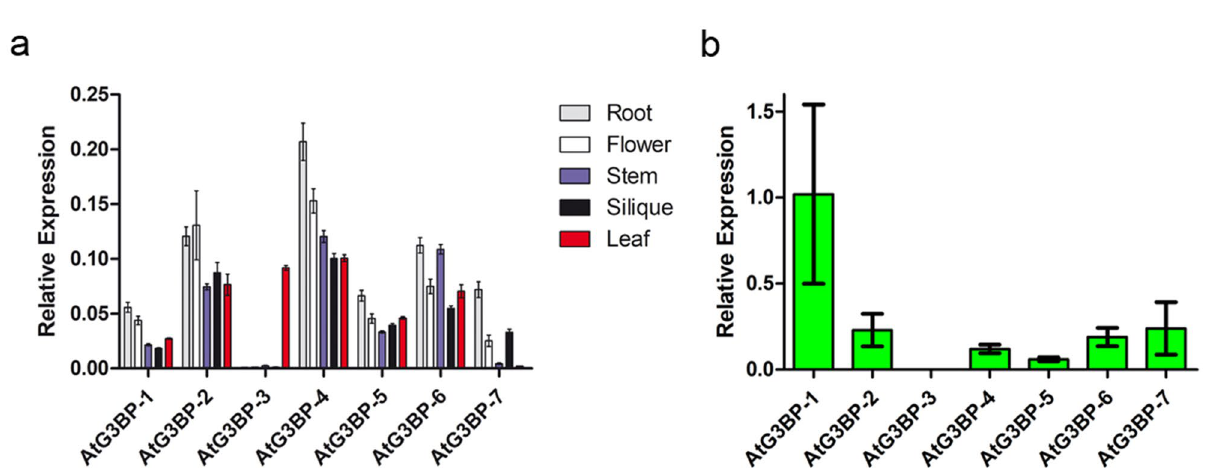
Figure 5. Expression level analyses. ( a ) qRT-PCR was used to measure the relative gene expression of the different AtG3BP s in roots, stem, flower, silique, and rosette leaves. Transcript levels were calculated using the 2 -∆Ct method with AtActin-2 as the endogenous control. The error bar represents the standard error. ( b ) Expression ratio of AtG3BP genes in phloem tissue compared to non-phloem tissue in A. thaliana leaves extracted by laser dissection of AtSUC2 promoter::GFP plants. Gene expression was normalized to AtActin-2 and expression levels were calculated using the 2 −∆Ct